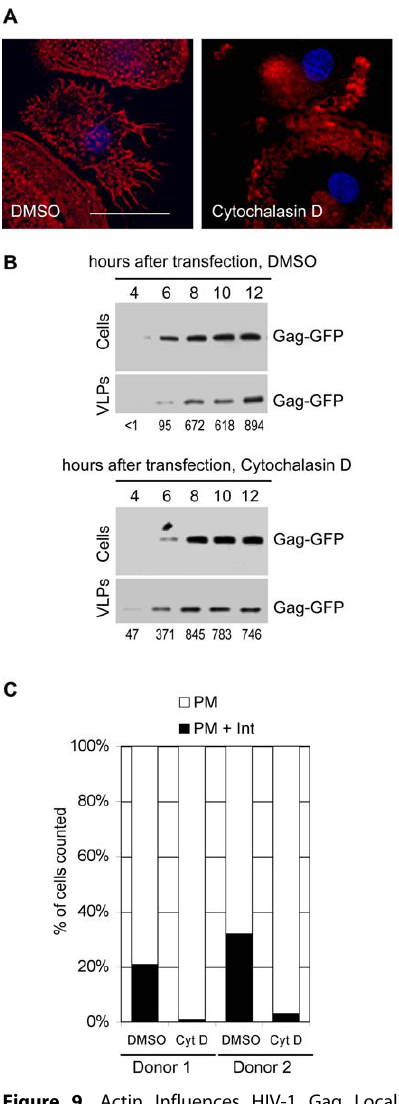
Figure 9. Actin Influences HIV-1 Gag Localization but Not Particle Release in Primary Human Macrophages (A) Disruption of microfilaments in macrophages. Macrophages treated with DMSO or cytochalasin-D were fixed 12 h after treatment and stained with phalloidin (red) and Hoechst 33258 (blue). Scale bars indicate 20 l m. (B) Western blot analysis of macrophages expressing Gag-GFP in the presence of DMSO or cytochalasin-D. Samples were collected every 2 h, from 4- to 12-h post-transfection. Cell and virion lysates were probed with anti–HIV-1 CA antibodies. Numerical values below the blots indicate VLP signal intensities, derived by densitometry. (C) Quantification of Gag-GFP distribution in macrophages in the absence of microfilaments. Macrophages expressing Gag-GFP were treated with DMSO or cytochalasin D for the entire duration of Gag-GFP synthesis. Cells were fixed at 12-h post-transfection, and the proportion of cells (of 100 counted) in which Gag was found at the PM, or at both internal sites and the PM was counted. DOI: 10.1371/journal.pbio.0040435.g009